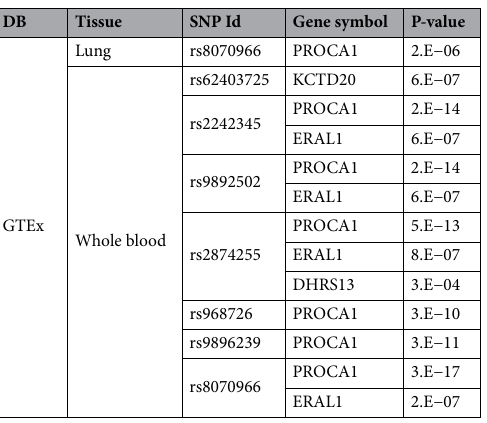
Table 5. eQTL among GWAS candidate SNPs in COPD patients. eQTL expression quantitative trait